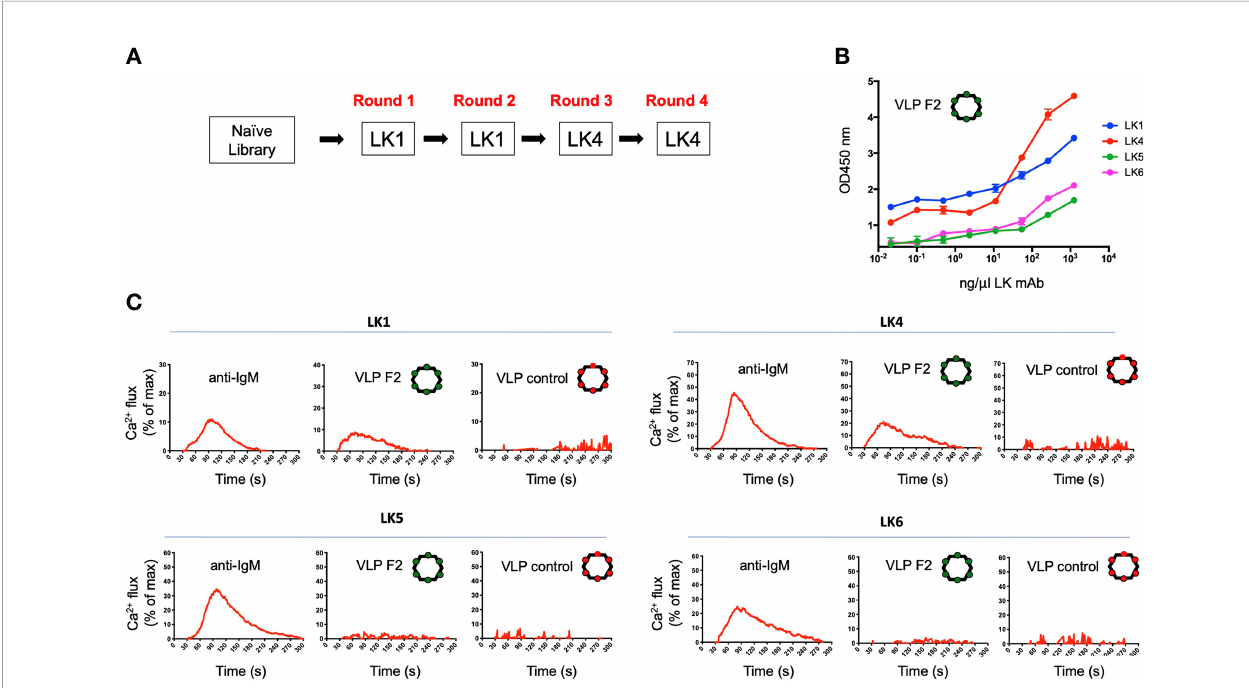
FIGURE 3 | Isolation of a VLP selectant with af fi nity for BCRs with IGHV1-2*02-encoded domains. (A) The VLP library underwent four rounds of positive selection using either LK1 and LK4 mAbs. After each round of selection, the VLPs were screened by ELISA for reactivity to LK1, LK4, LK5 and LK6. (B) The VLP-F2 displaying the peptide sequence HMRGGAYATD was isolated which showed af fi nity for LK1 and LK4 mAbs (mean ± SD, n = 3 replicates), but not LK5 or LK6 mAbs (see other VLP reactivity pro fi les in Figure S1 ). (C) IGHV1-2*02-depedent BCR triggering activity by VLP-F2. To con fi rm that selective af fi nity for the IGHV1- 2*02 germline domain translated into V H -gene-selective BCR activation, the LK antibodies were stably expressed as IgM BCRs in an engineered B cell reporter line that enables monospeci fi c display of user de fi ned BCRs (59). BCR activation was measured kinetically by Ca 2+ fl ux using the ratiometric dye Fura Red. Following baseline acquisition (20s), LK BCRs were exposed to anti-IgM, VLP-F2 or VLP-control and the data was acquired for 300s. The baseline reading was then subtracted and the Ca 2+ fl ux values were standardized to total cell Ca 2+ fl ux capacity as de fi ned by exposure to the ionophore ionomycin. Each run represents the average of two independent fl uxes per